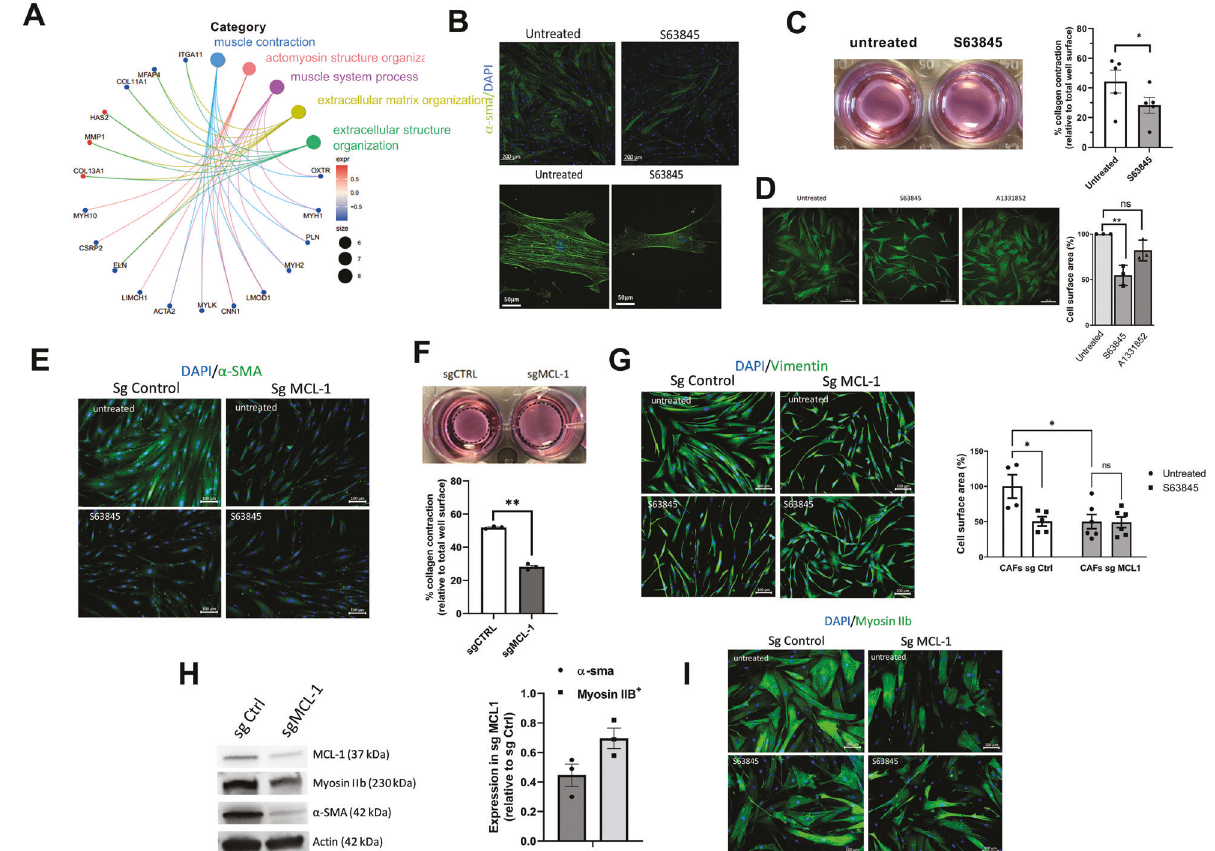
Fig. 2 MCL-1 antagonist mitigates myo fi broblastic features. A Gene Ontology (GO) pathway enrichment analysis based on DGE results. B Representative immuno fl uorescence of α -smooth muscle actin ( α -SMA) (green) in CAF treated or not with S63845 for 18 h, nuclei were stained in blue (4 ’ ,6-diamidino-2-phenylindole, DAPI) ( n = 3). C Representative images of CAFs contraction of collagen gels. Quanti fi cation of collagen gel contraction by CAFs treated or not with S63845. 100% represents the total surface area of the well ( n = 5) Student t -test, * P < 0.05. D Representative immunocytochemistry of Vimentin immunostaining used to determine cells surface area of 3 different CAFs treated or not with S63845 500 nM or A1331852 100 nM for 18 h. Cells area were determined with imageJ software by measuring average of cell surface area from 200 cells for each condition, results are expressed in arbitrary unit relative to untreated cells. Anova, ** P < 0.01, ns: not signi fi cant. E Representative immuno fl uorescence of α -smooth muscle actin ( α -SMA) (green) in CAFs knock down for MCL-1 (Sg MCL-1) or not (Sg control), nuclei were stained in blue (4 ’ ,6-diamidino-2-phenylindole, DAPI) ( n = 3). F Representative images of CAFs contraction of collagen gels. Quanti fi cation of collagen gel contraction by CAFs knock down for MCL-1 (Sg MCL-1) or not (Sg Control). 100% represents the total surface area of the well. ( n = 3) Student t -test, ** P < 0.01. G Representative immunocytochemistry of Vimentin immunostaining used to determine cells surface area of 3 different CAFs Sg Control or Sg MCL-1. Cells area were determined with imageJ software by measuring average of cell surface area from 200 cells for each condition, results are expressed in arbitrary unit relative to untreated cells. Anova, * P < 0.05, ns: not signi fi cant. H (Left) Representative experiment of protein expression level (MCL-1, Myosin IIB, α -SMA) evaluated using western blots, Actin expression was used as loading control. (Right) Quanti fi cation of the amounts of α -SMA or Myosin IIB protein band relative to Actin in CAFs Sg MCL-1, results are expressed as a ratio relative to Sg Control. I Representative immuno fl uorescence of Myosin IIB (green) in CAFs knock down for MCL-1 (Sg MCL-1) or not (Sg control), nuclei were stained in blue (4 ’ ,6-diamidino-2-phenylindole, DAPI) ( n =